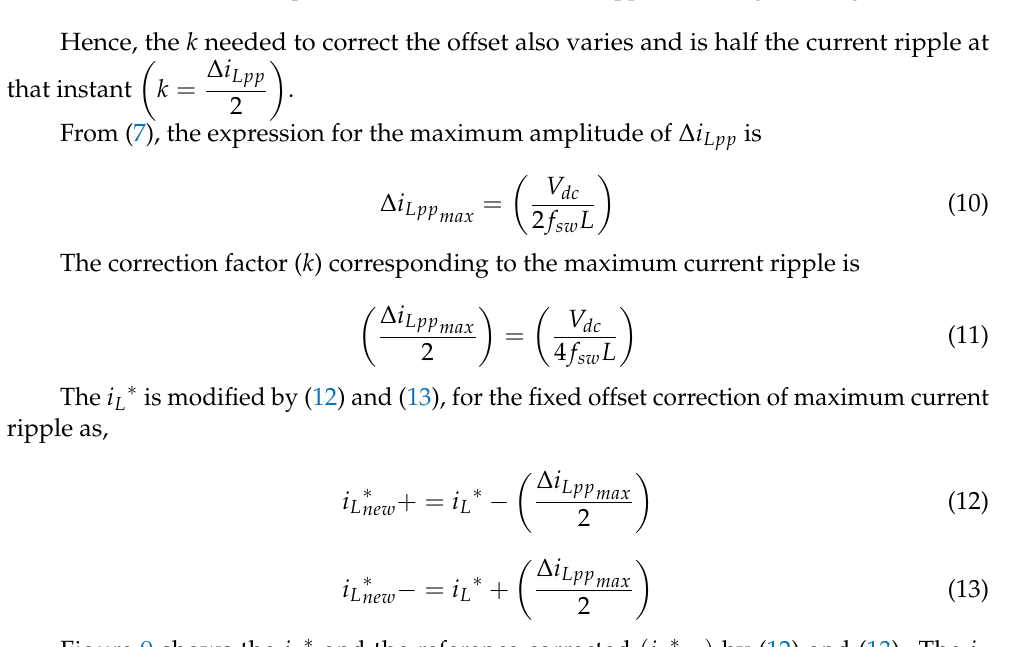
Figure 8. Variation in the amplitude of the inductor current ripple with the grid voltage.